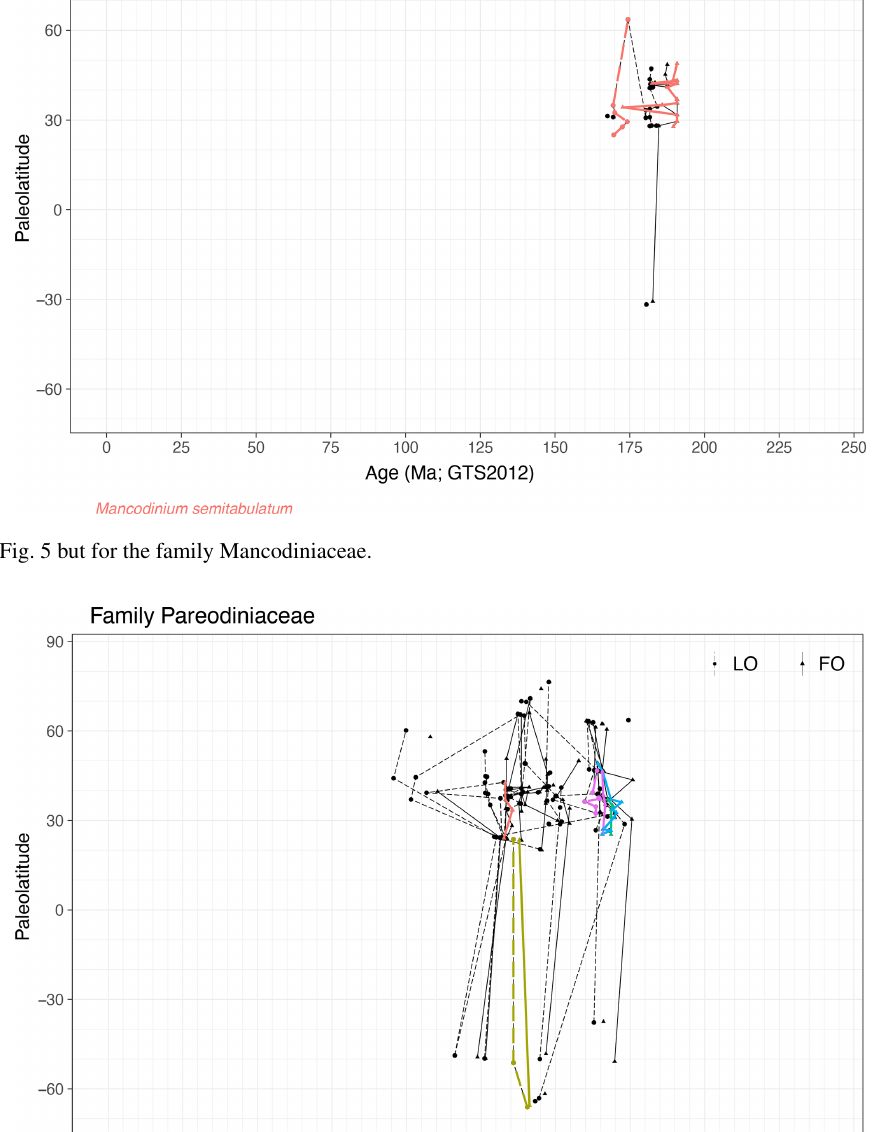
for the longest in low and middle latitudes.